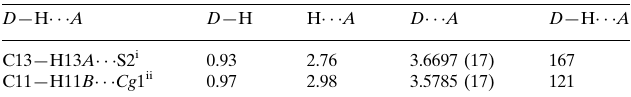
Hydrogen-bond geometry (A˚ , (cid:1)